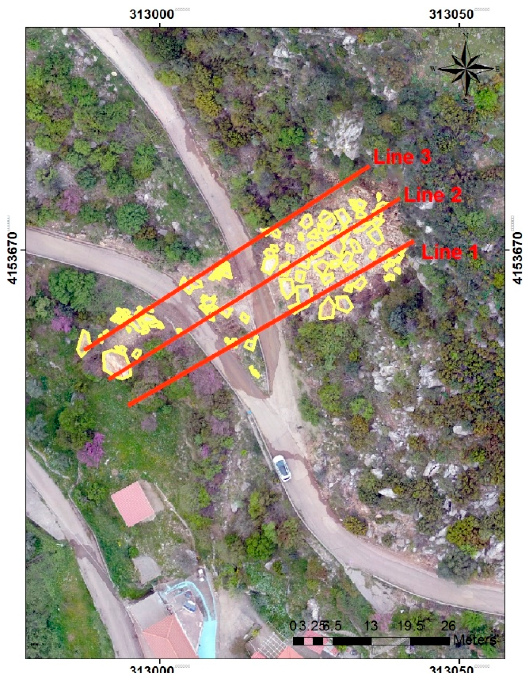
Figure 6. Picture of the rockfall in Myloi region, illustrating the final position of rock blocks.